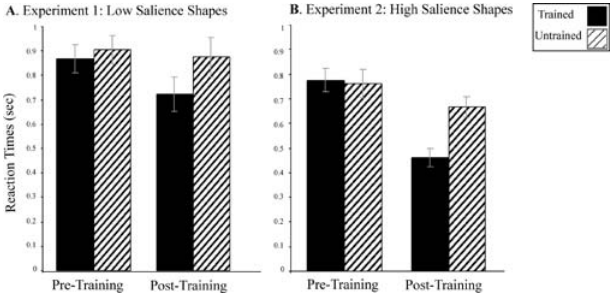
Reaction times before and after training for Experiments 1 (A) and 2 (B). Error bars are plus or minus the SEM. DOI: